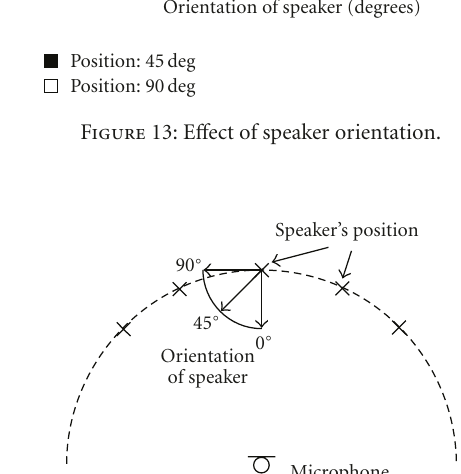
Figure 12: Comparison of performance using di ff erent test segment lengths.